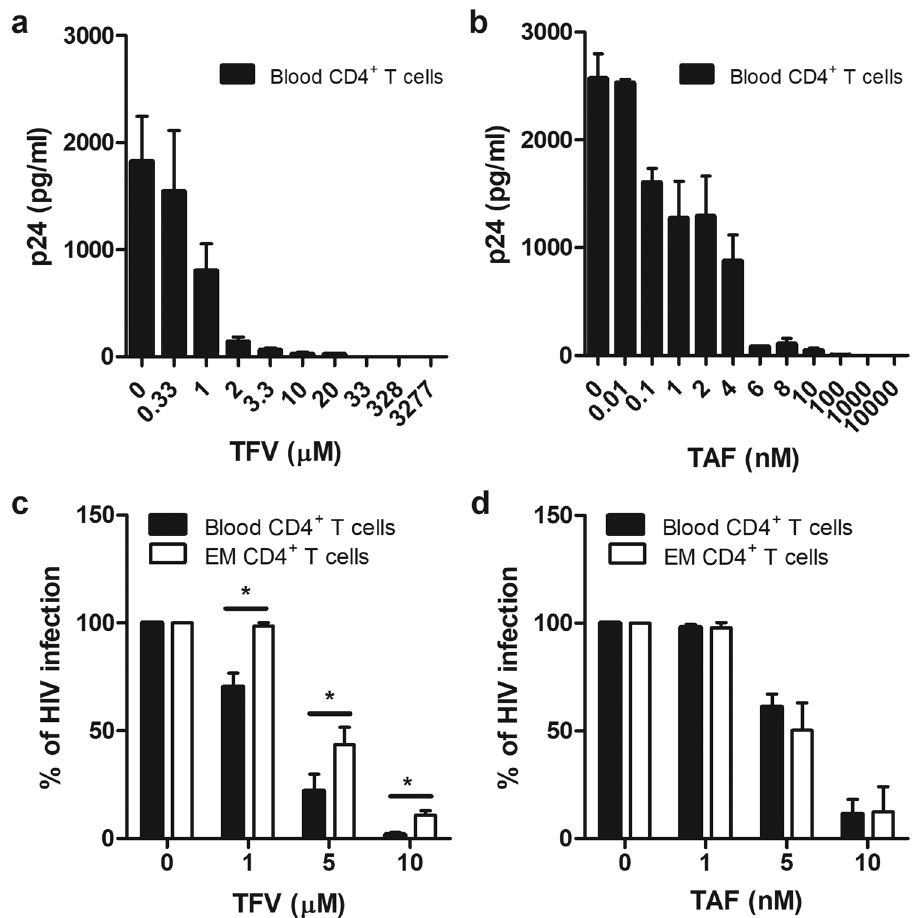
Figure 2. Dose response and comparison of TFV and TAF inhibition of HIV infection of CD4 + T cells from blood and endometrium (EM). Activated CD4 + T cells from blood and endometrium were pre-treated with TFV or TAF for 24hr and inoculated with HIV for 2hr. Released p24 levels in the culture media after 5 days of infection were measured by p24 enzyme-linked immunosorbent assay. Released p24 levels into the culture media after 5 days of infection when blood CD4 + T cells from same female donor were pre-treated with indicated doses of TFV ( a ) or TAF ( b ). The bar represents the mean and SEM from triplicate cultures. Effect of increasing concentrations of TFV ( c ) and TAF ( d ) on inhibition of HIV in CD4 + T cells from blood (n = 6) and endometrium (n = 3). Data were normalized to % of HIV infection with respect to infected control without TFV or TAF pre-treated. The bar represents the mean and SEM. * p <